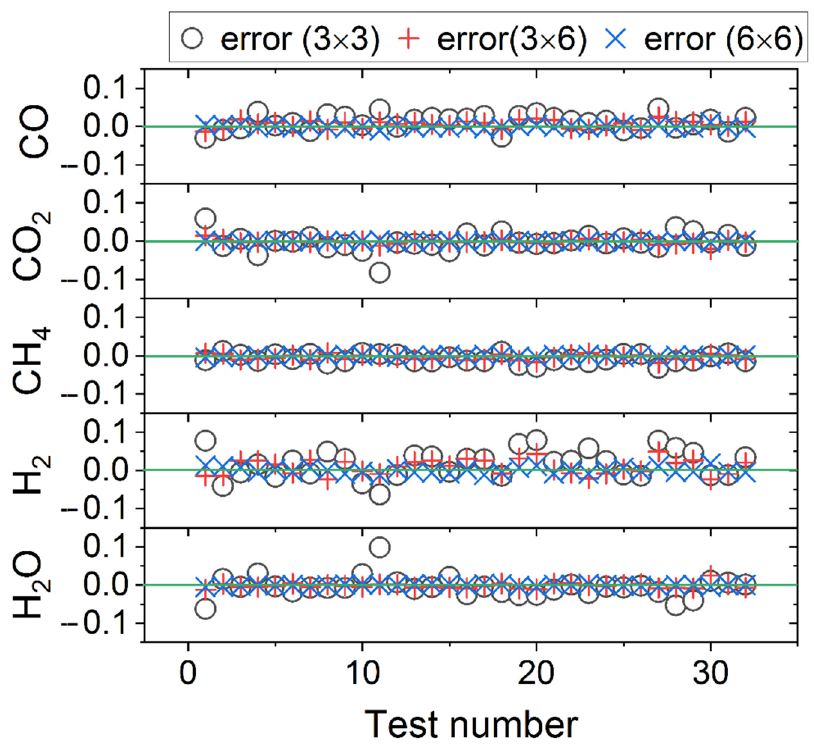
Figure 7. Prediction errors of BRM products.